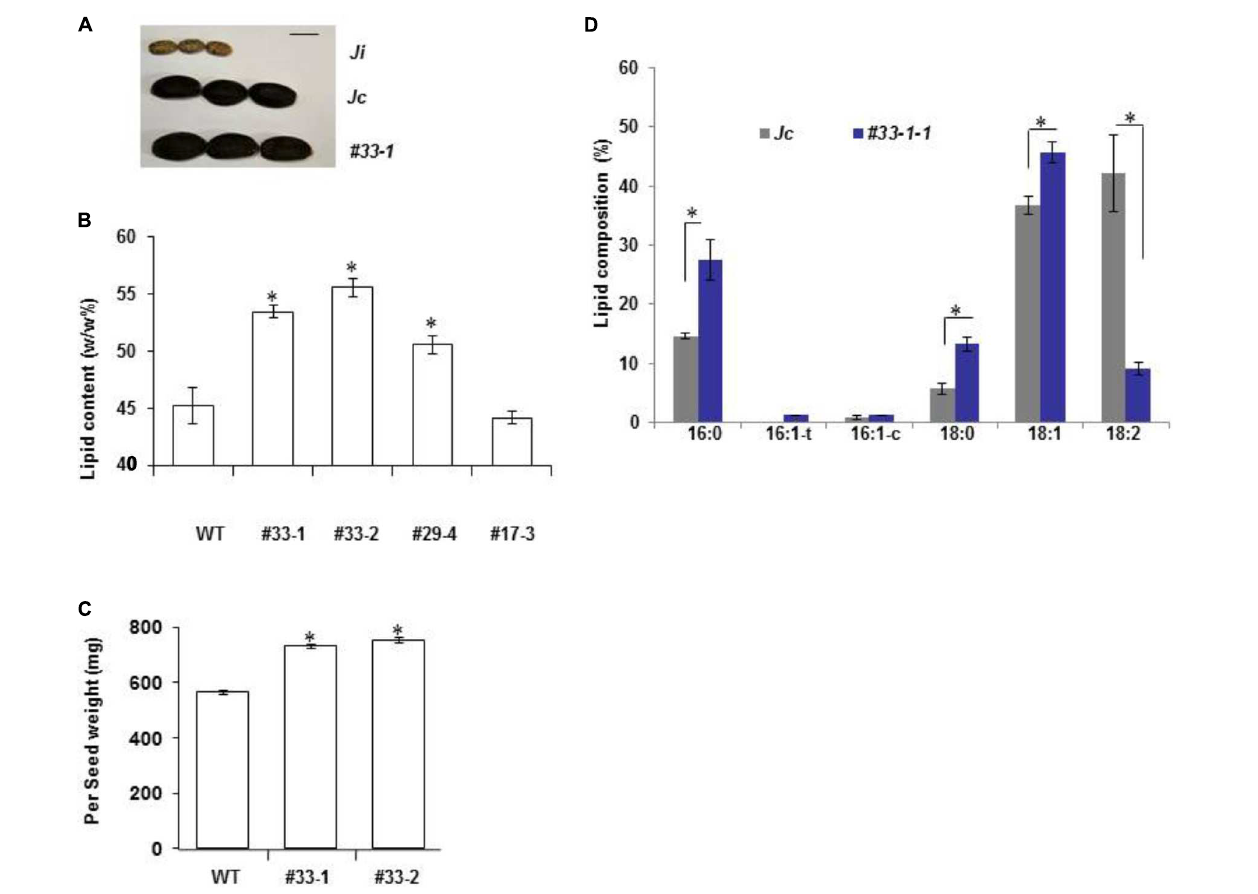
FIGURE 6 | Overexpression of JcWRI1 increases seed size and lipid content in J. curcas seeds. (A) Seed size of J. curcas ( Jc ), J. integerrima ( Ji ), and T2 seeds of transgenic J. curcas overexpressing JcWRI1 (#33-1). Bar: 10 mm. (B) Total lipid content (lipid weight/endosperm weight) consistently increased in T2 seeds of transgenic J. curcas overexpressing JcWRI1 (#33-1, #33-2, and #29-4 are corresponding T2 progeny of T1 plants shown in Supplementary Figure S1B ). WT (wild type) is non-transgenic J. curcas control seeds. Values are mean ± SD ( n = 10) with statistical analysis by Student’s t -test ( ∗ indicates p < 0.05). (C) Increase of seed weight in transgenic J. curcas plants overexpressing JcWRI1 . T2 seeds (#33-1and #33-2) were used. Values are mean ± SE ( n = 30) with statistical analysis by Student’s t -test ( ∗ indicates p < 0.05). (D) Statistic analysis of lipid profile in T3 seeds of J. cucas plants overexpressing JcWRI1 . Values are mean ± SD of five seed replicates with statistical analysis by Student’s t -test ( ∗ indicates p <